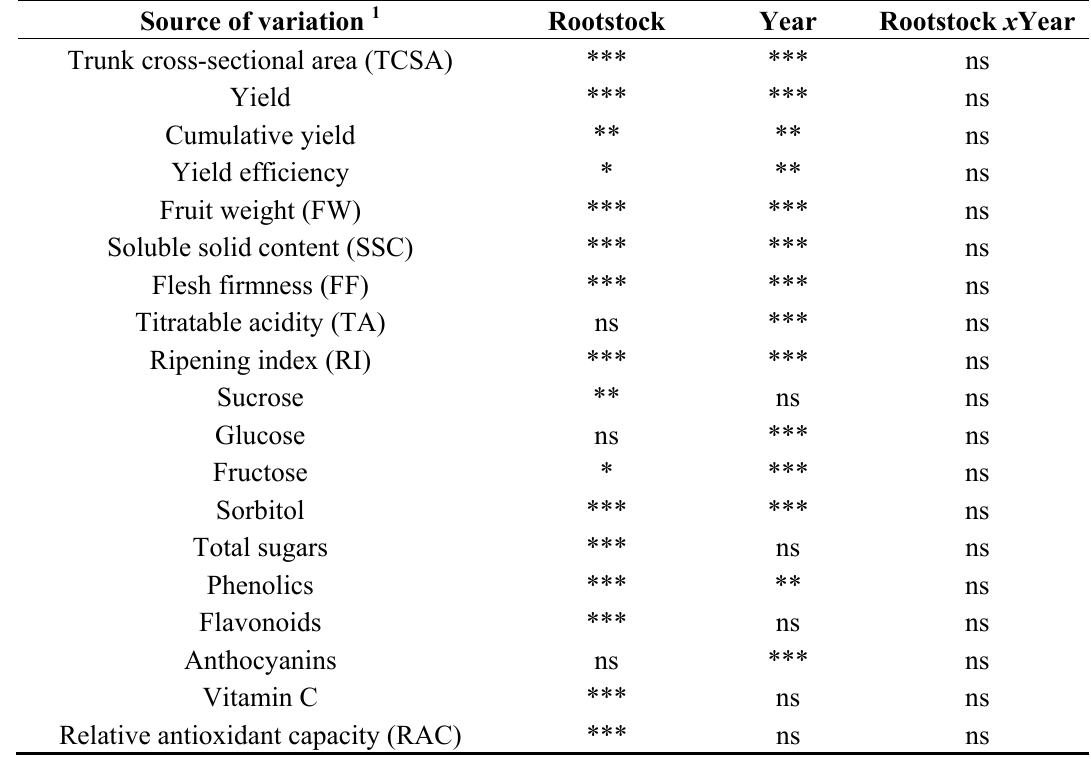
Table 1. ANOVA analysis of the effect of rootstock and year on agronomic and fruit quality traits in “Catherine” cultivar for the average of the years of study.